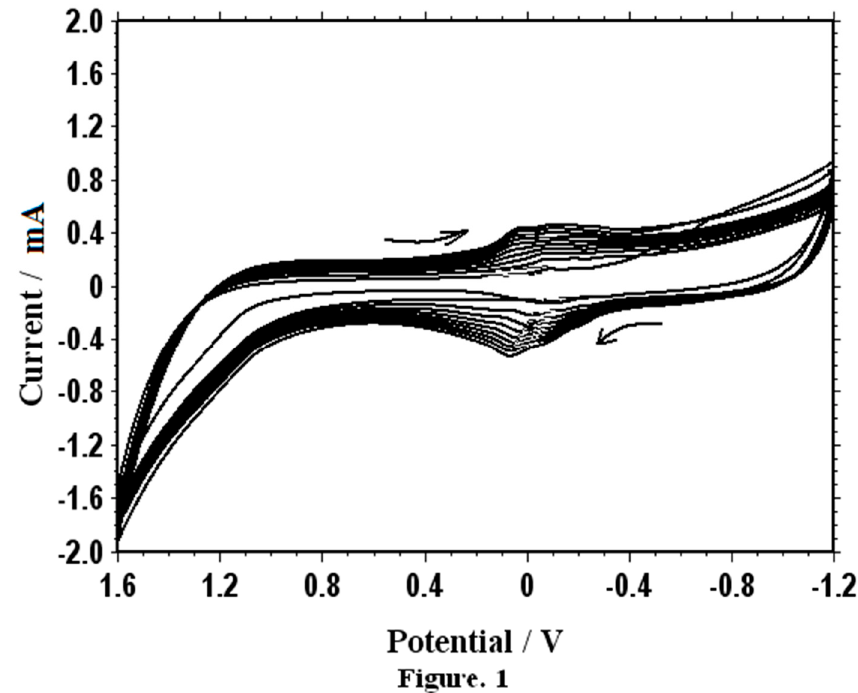
Figure 1. Cyclic voltammograms for electrochemical polymerization of methionine on a bare carbon paste electrode (BCPE) in 0.1 M phosphate-buffered saline (PBS) pH 7.0 by 20 segments. Sweep rate: 100 mV ∙ s − 1 .